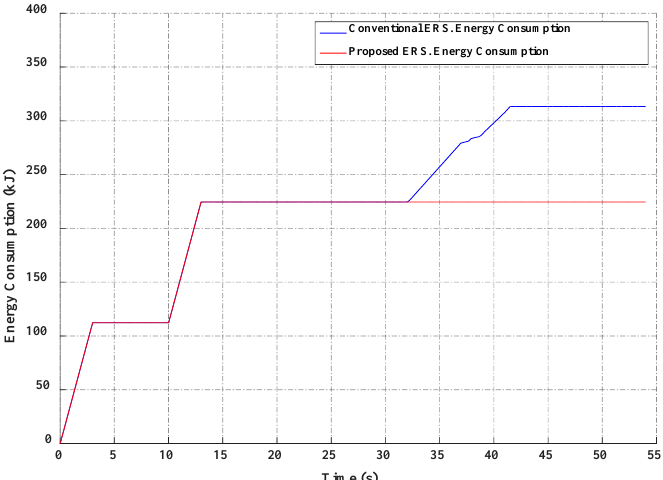
Figure 16. Comparison of energy consumption of the conventional ERS and proposed ERS.